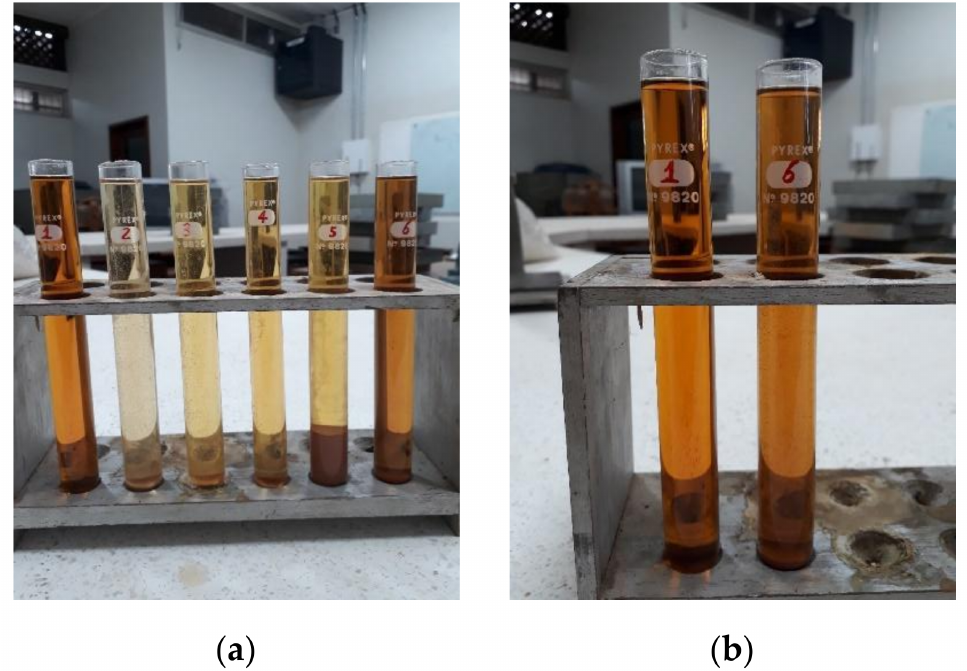
Figure 5. Evaluation of organic impurity of the waste collected in the construction sites: ( a ) display showing all the samples examined (reference solution of tannic acid on the left); ( b ) display show- ing the reference solution of tannic acid ( left ) and the solution obtained from the finishing stage residue ( right